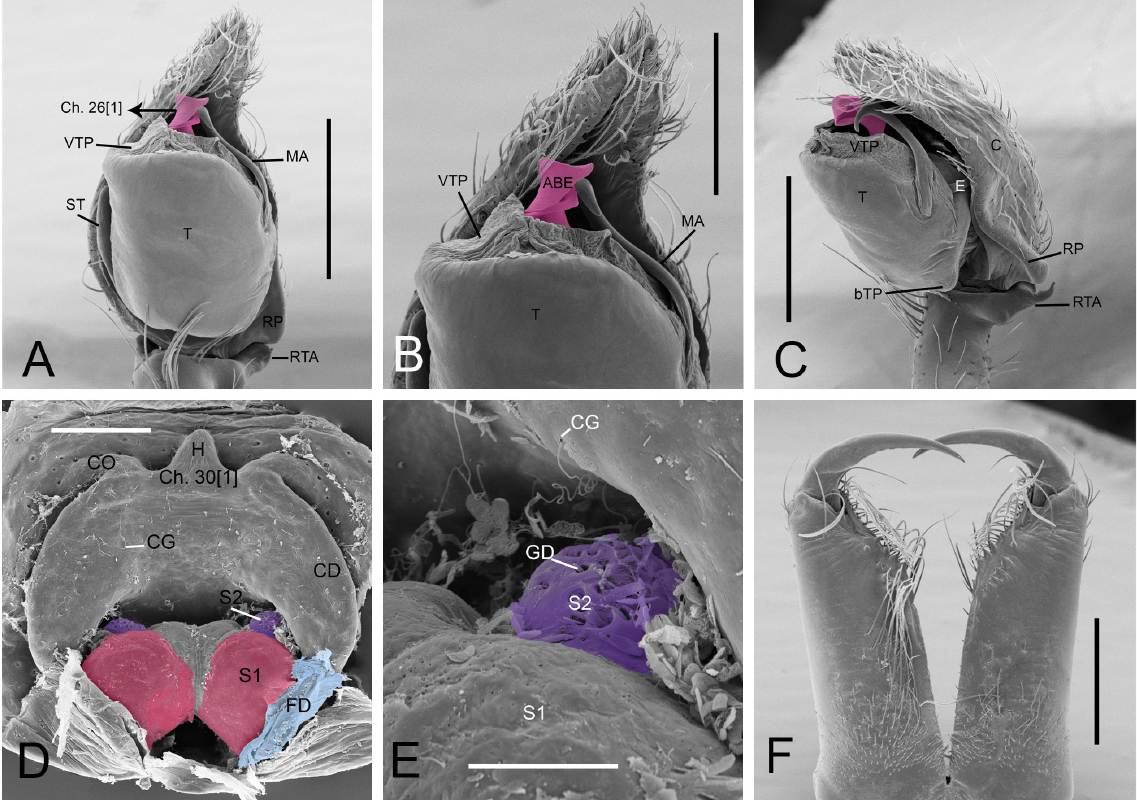
Fig. 26. Tafana maracay sp. nov. (A–C, F = ♂, MNHN 11314; D–E = ♀, MNHN 11314). A . Left palp, ventral view (arrow indicating character). B . Left palp, ventral view. C . Left palp, retrolateral view. D . Vulva, dorsal view. E . Vulva, dorsal view, details of spermathecae. F . Chelicerae, ventral view. Abbreviations: ABE = apophysis of base of the embolus; bTP = basal tegular protuberance; C = cymbium; CD = copulatory ducts; CG = cuticular glands; Ch = character; CO = copulatory opening; E = embolus; FD = fertilization ducts; GD = gland ducts; H = hood; MA = median apophysis; RP = retrolateral projection; RTA = retrolateral tibial apophysis; S1 = primary spermathecae; S2 = secondary spermathecae; ST = subtegulum; T = tegulum; VTP = ventral tegular process. Scale bars: A, C, F = 0.5 mm; B = 0.3 mm; D = 0.1 mm; E = 0.03